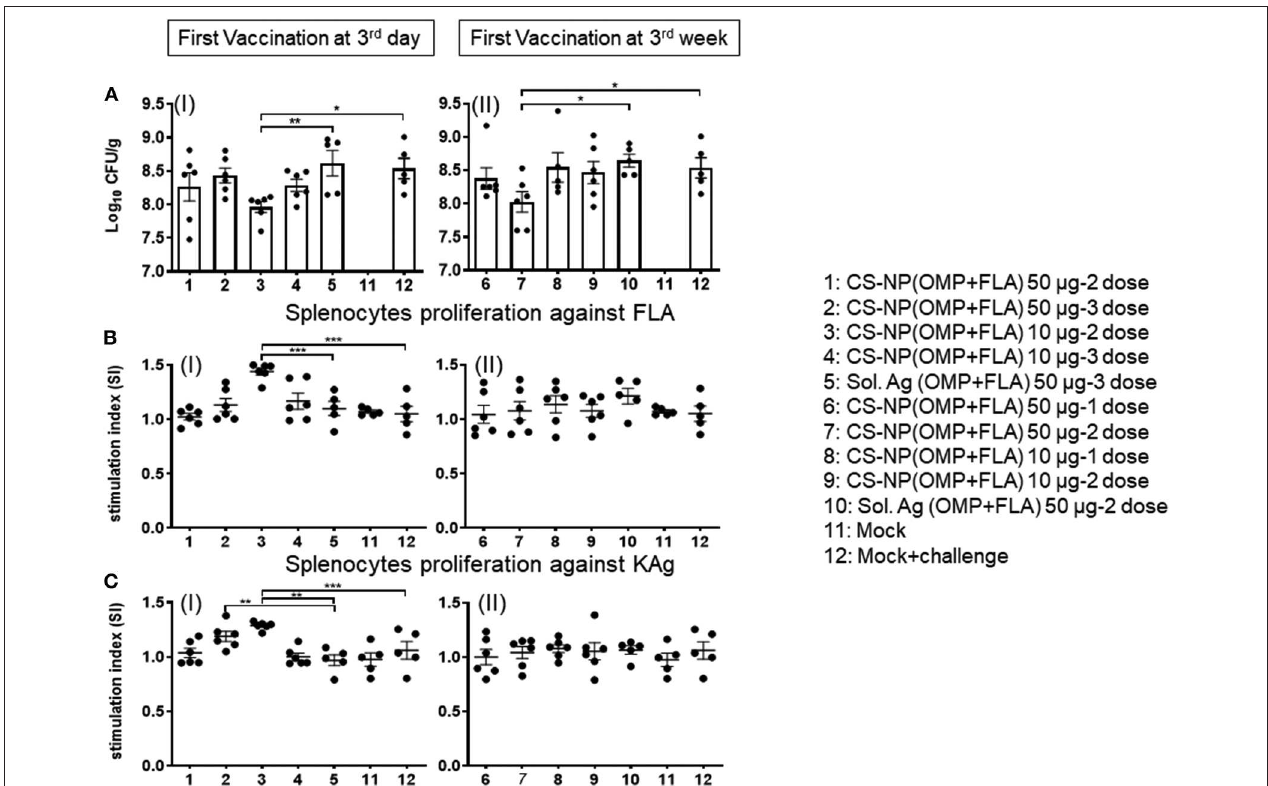
FIGURE 4 | SE load in the cecal content of vaccinated and challenge birds, and Salmonella specific lymphocytes proliferation response in splenocytes. (A) Salmonella CFU was enumerated in cecal content by plating on XLD agar plates (I and II). (B,C) Splenocytes harvested on the day of necropsy were stimulated with (B) FLA protein (I and II) or (C) KAg (I and II) for 48h and lymphocytes stimulation index (SI) value was calculated by the mean OD of specific antigen (FLA/KAg) stimulated proliferation/mean OD of non-stimulated proliferation by a colorimetric assay. Each bar is the mean ± SEM of 6 or 5 birds. Significant differences were calculated between vaccinated and Sol. Ag (OMP + FLA) or mock group by one-way ANOVA followed by Tukey post-hoc test. * P < 0.05, ** P < 0.01, *** P < 0.001.